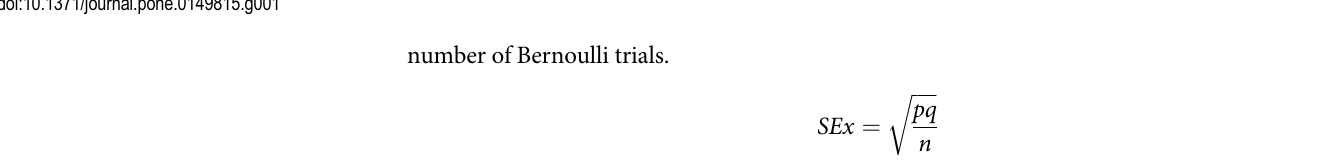
Fig 1. Experimental conditioning procedure. In single stimulus tests, either blue light or vanillin were paired with the host plant. In compound conditioning, all test groups received simultaneous presentation of the visual and olfactory stimuli.